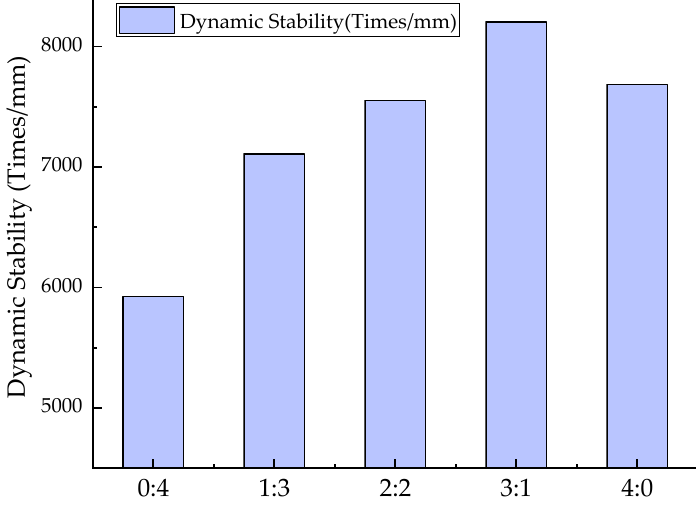
Figure 3. High-temperature stability test at 70 °C.